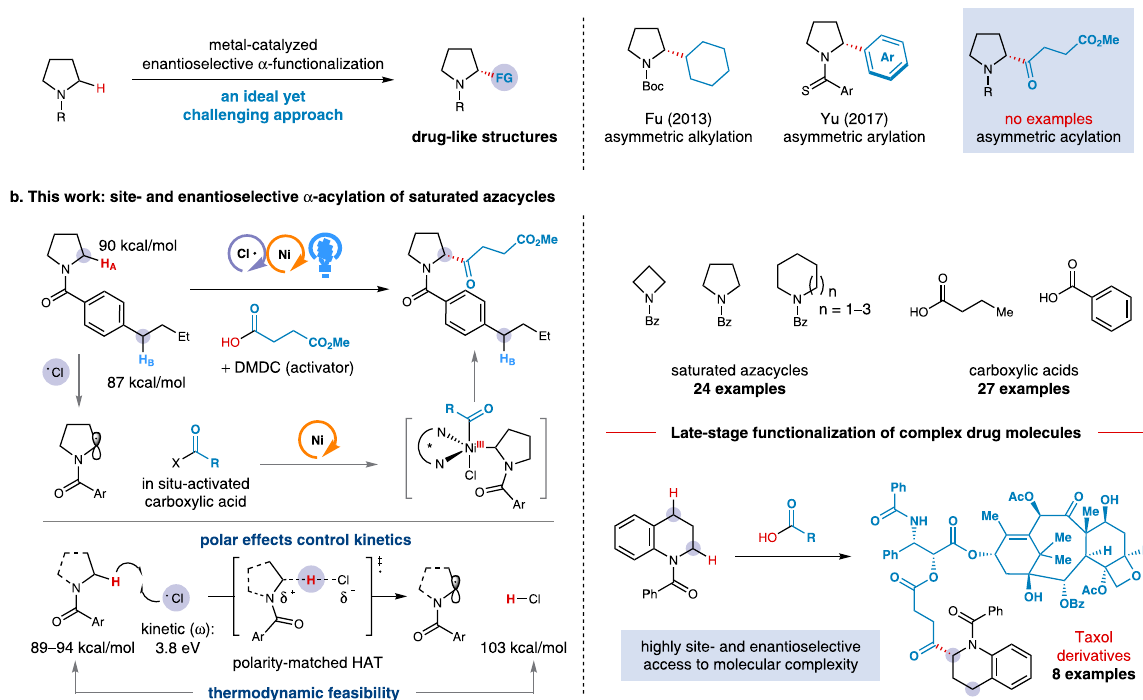
Fig. 1 | Approachesfortransitionmetal-catalyzedenantioselective α -functionalization ofsaturated azacycles.a Priorartforenantioselective α -functionalizationof saturated azacycles. b This work: site- and enantioselective α -acylation of saturated azacycles. DMDC dimethyl